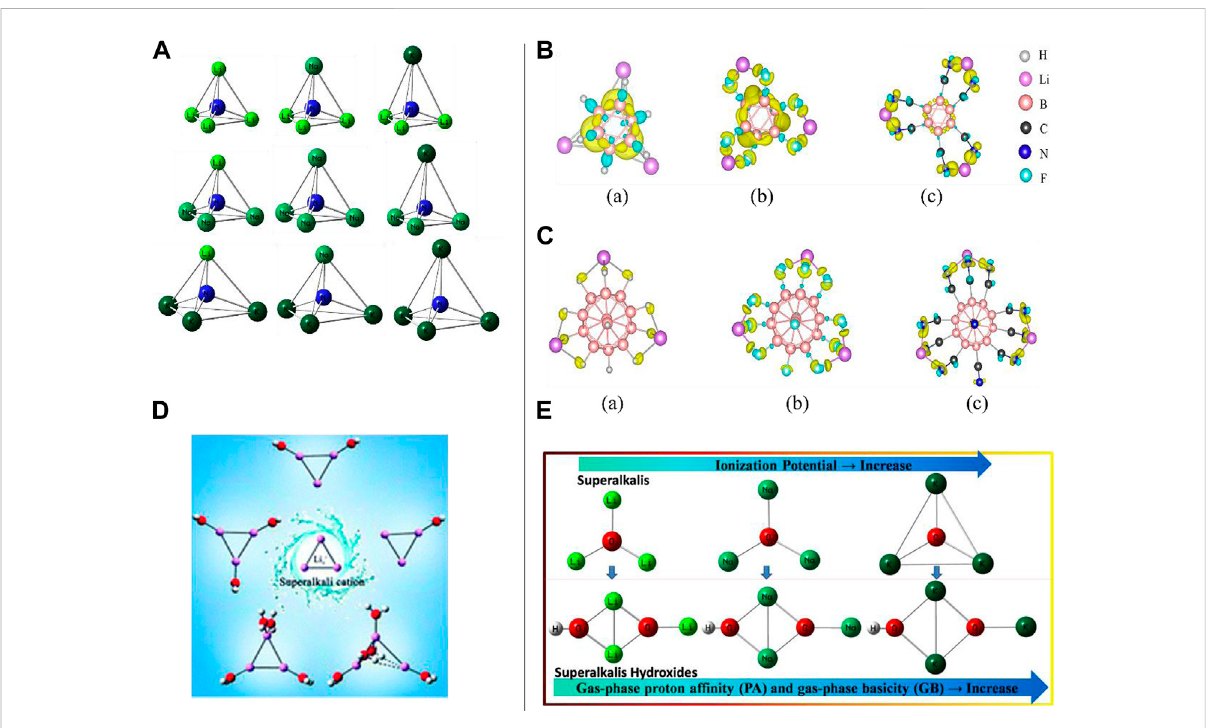
FIGURE 1 (A) Geometric structures of NM 4 (M = Li, Na, and K) clusters reproduced from Zhang and Chen (2019); (B) charge density difference in (A) Li 3 B 6 H 6 , (B) Li 3 B 6 F 6 ,and (C) Li 3 B 6 (CN) 6 clustersreproducedfromBanjadeetal.(2021). (C) Chargedensitydifferencein (A) Li 3 B 12 H 12 , (B) Li 3 B 12 F 12 ,and (C) Li 3 B 12 (CN) 12 clusters(Banjadeetal.,2021); (D) superalkalicationLi 3 + withwatermolecules,Li 3 + (H 2 O) n ( n =1 –